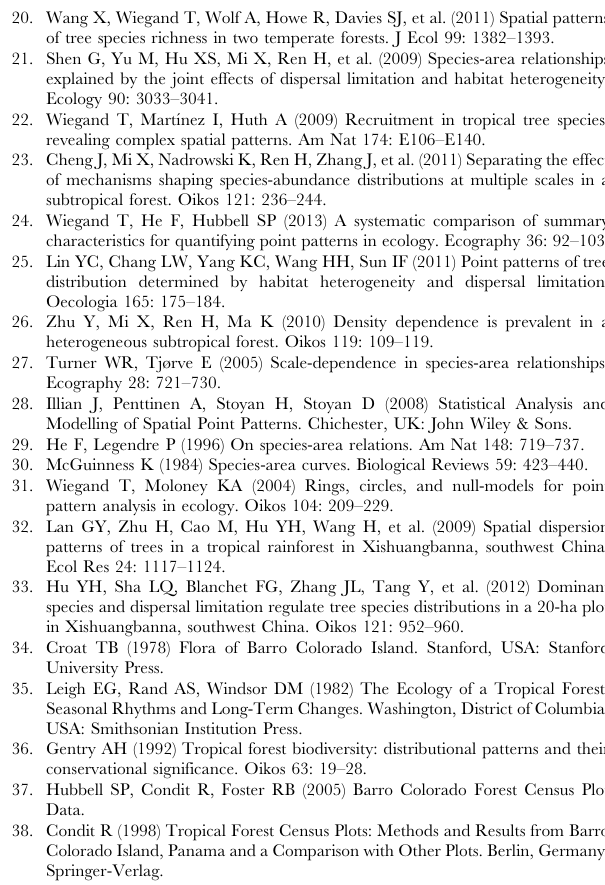
size-class effect. The units of x and y axes are meter. See Figure 4 for the abbreviations. Figure S4 The real distribution of Alchornea tiliifolia in the Bubeng plot; its distributions predicted from the inhomogeneous Poisson process, the inhomogeneous Thomas process and the homogeneous Thomas process with the size-class effect; and its distributions predicted from the inhomogeneous Thomas process and the homogeneous Thomas process scenarios without the size- class effect. The units of x and y axes are meter. See Figure 4 for the abbreviations. Figure S5 The real distribution of Castanopsis echidnocarpa in the Bubeng plot; its distributions predicted from the inhomoge- neous Poisson process, the inhomogeneous Thomas process and the homogeneous Thomas process with the size-class effect; and its distributions predicted from the inhomogeneous Thomas process and the homogeneous Thomas process scenarios without the size- class effect. The units of x and y axes are meter. See Figure 4 for the abbreviations. Figure S6 The real distribution of Knema furfuracea in the Bubeng plot; its distributions predicted from the inhomogeneous Poisson process, the inhomogeneous Thomas process and the homogeneous Thomas process with the size-class effect; and its distributions predicted from the inhomogeneous Thomas process and the homogeneous Thomas process scenarios without the size-